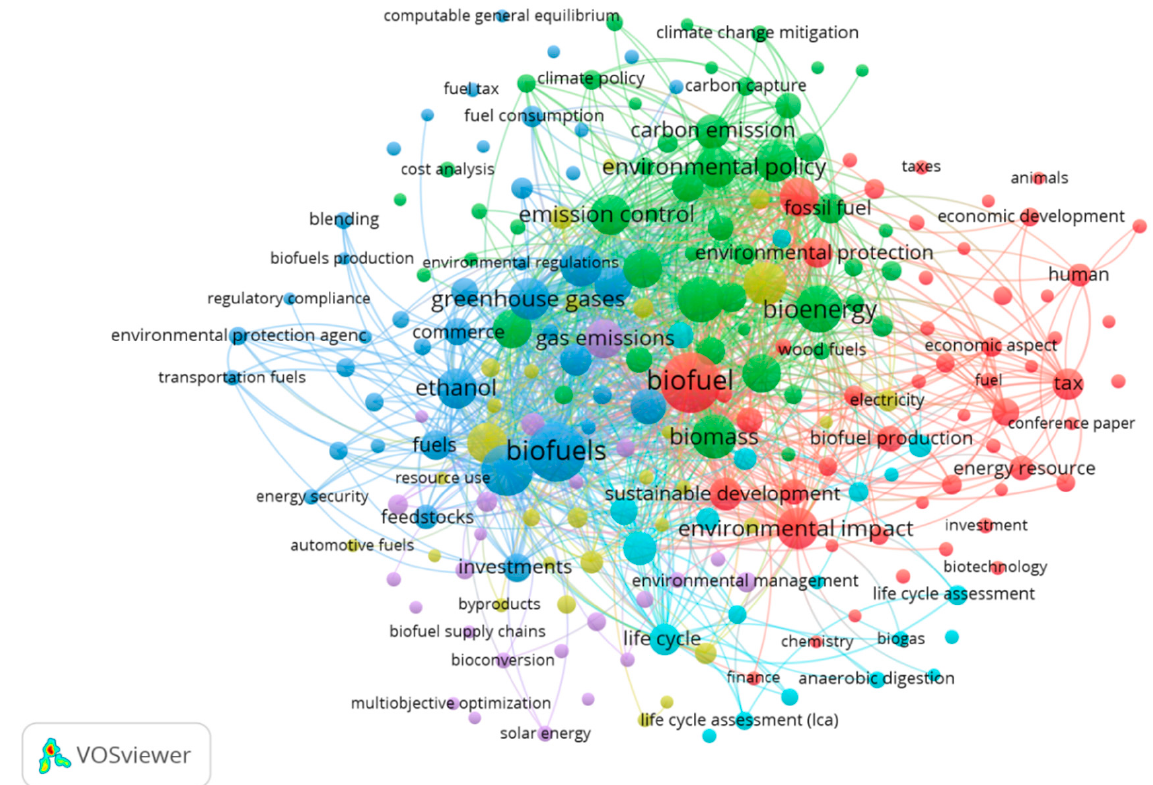
Figure 7. Results of bibliometric analysis of co-occurrence keywords on the request “environmental tax” and “bioenergy” or “biofuel”.